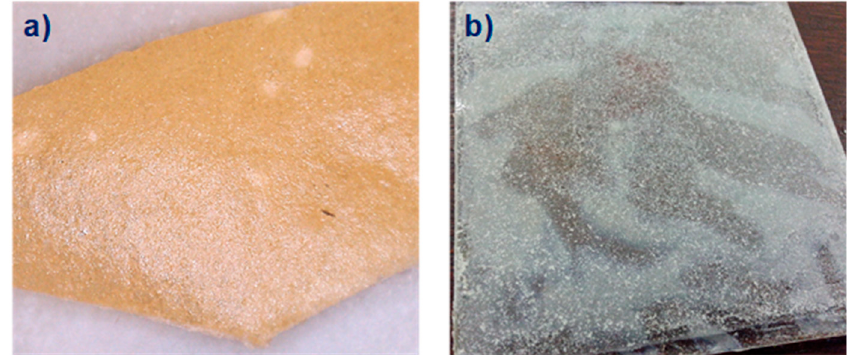
Figure 2. ( a ) Photograph of a PVPA/5% MgO coating showing regions of inhomogeneity (e.g., circled); ( b ) residual film of PVPA/1% MgO left on PMMA after a second water soak.